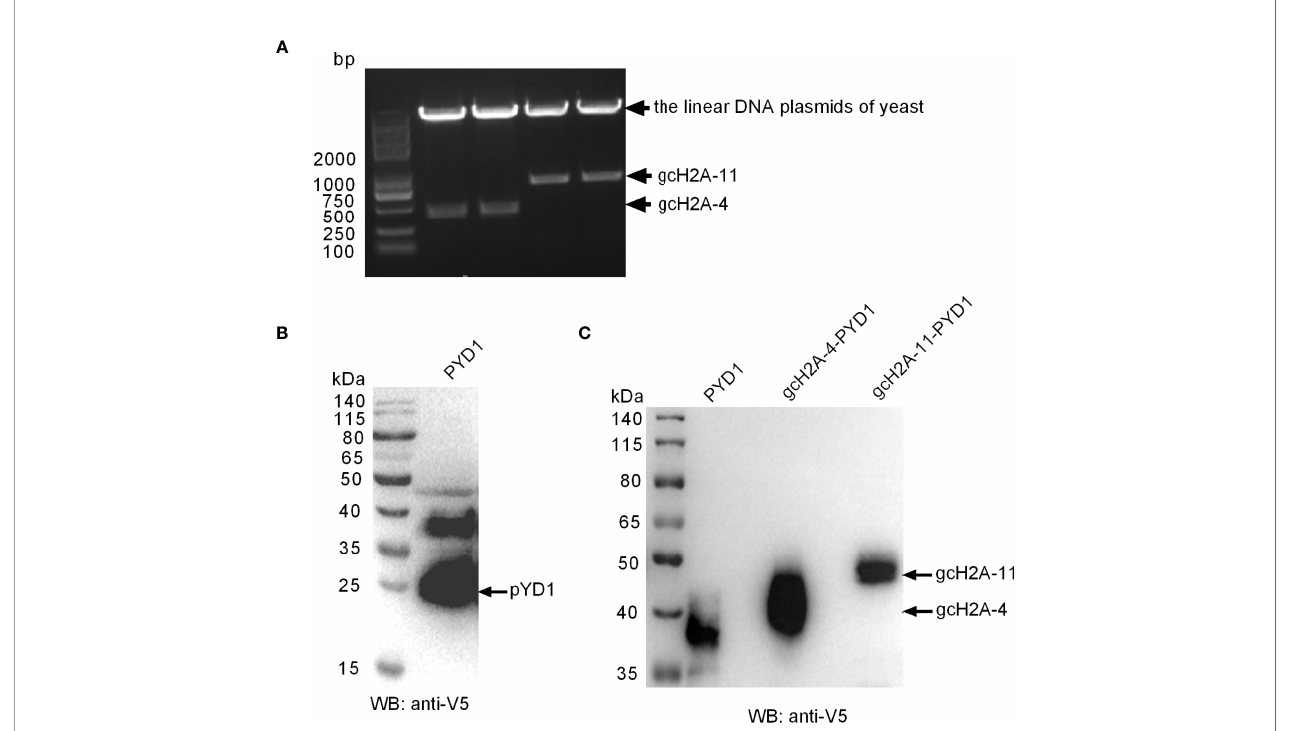
FIGURE 3 | The recombinant expressions of gcH2A-4 and gcH2A-11 in the S. cerevisiae strain. (A) Validation of the recombinant gcH2A-4 − PYD1 and gcH2A-11 − PYD1 plasmids using Bam H I/ Eco R I double restriction enzyme digestion. (B) Western Blotting of the cell lysates transformed with the PYD1 empty plasmid. (C) Western Blotting of the cell lysates transformed with PYD1, gcH2A-4 − PYD1 or gcH2A-11 −